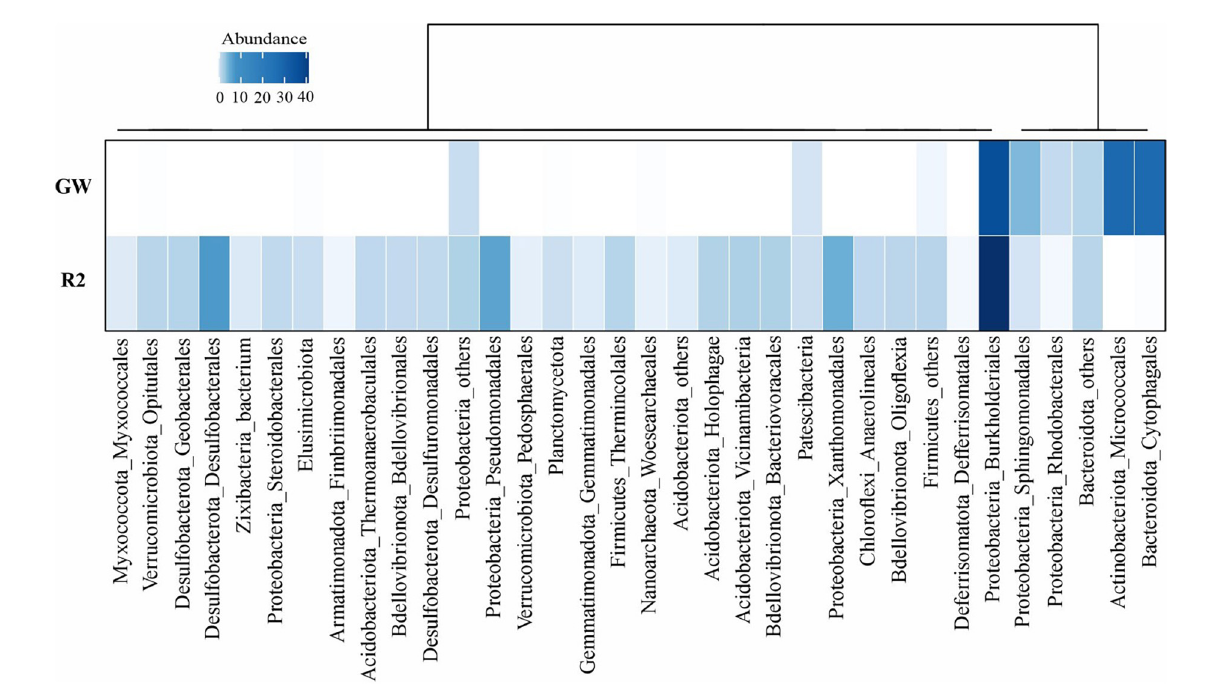
FIGURE4 Prokaryotic community composition of the groundwater samples according to the abundance of 16S rDNA gene reads in unassembled metagenomes. Rows are the name of samples (GW: unpolluted and R2: phenol polluted groundwater). Column names are microbial taxa at the phylum and order level. For some taxa with lower frequency, the sum of orders is displayed as others or in their corresponding higher taxonomic level. There are a total number of 34 taxa for both samples. Dendrograms represent the clustering of columns based on Pearson correlation. The figure was plotted using “circlize” and “ComplexHeatmap” packages in